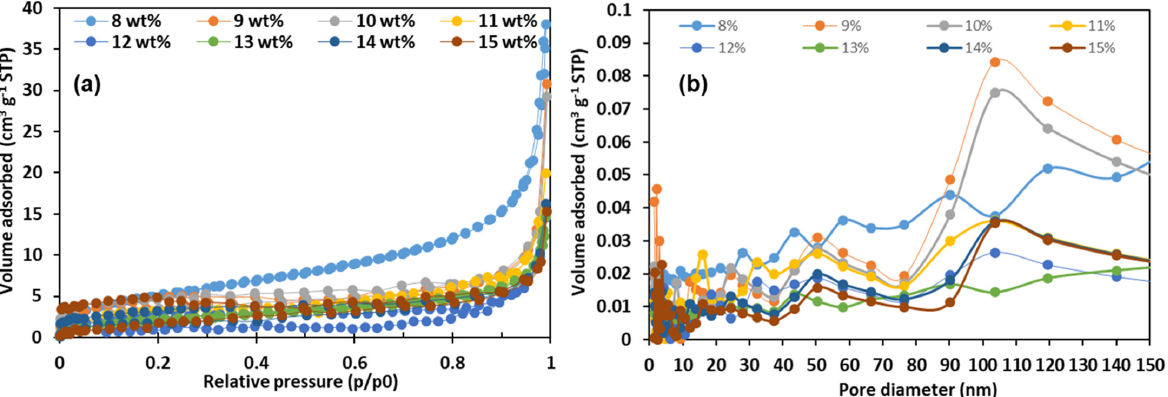
Figure 6. Nitrogen adsorption–desorption isotherms ( a ), and BJH adsorption pore size distribution ( b ) for all samples.